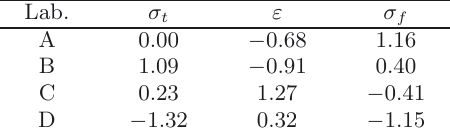
Table 5. Calculated Z-score